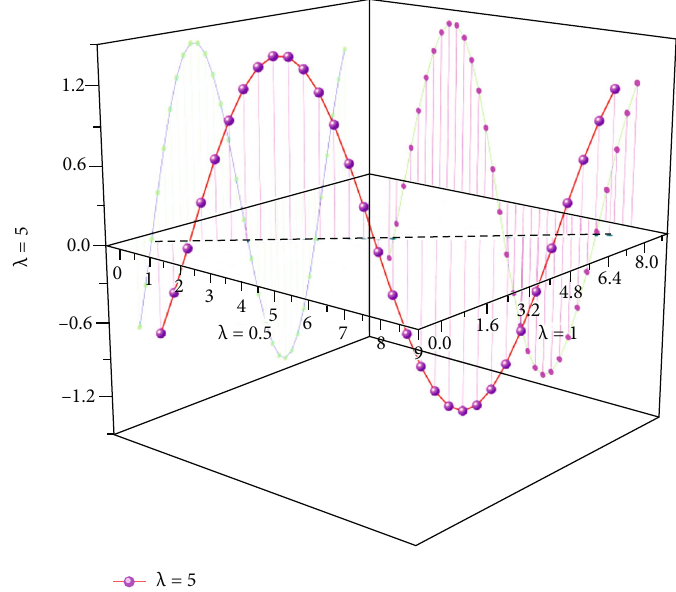
Figure 2: Images of the sigmoid function and hyperbolic tangent function at di ff erent λ